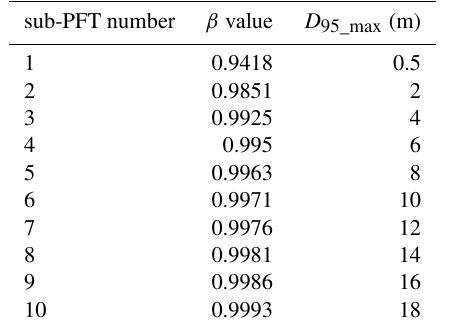
Table A2. β values assigned to the 10 sub-PFTs of each tropi- cal PFT (evergreen and deciduous) in LPJmL4.0-VR and the cor- responding maximum rooting depth reached by 95% of the roots ( D 95_max